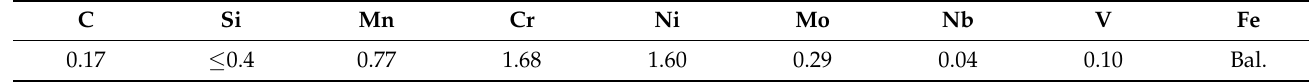
Table 1. Chemical composition of 17Cr2Ni2MoVNb